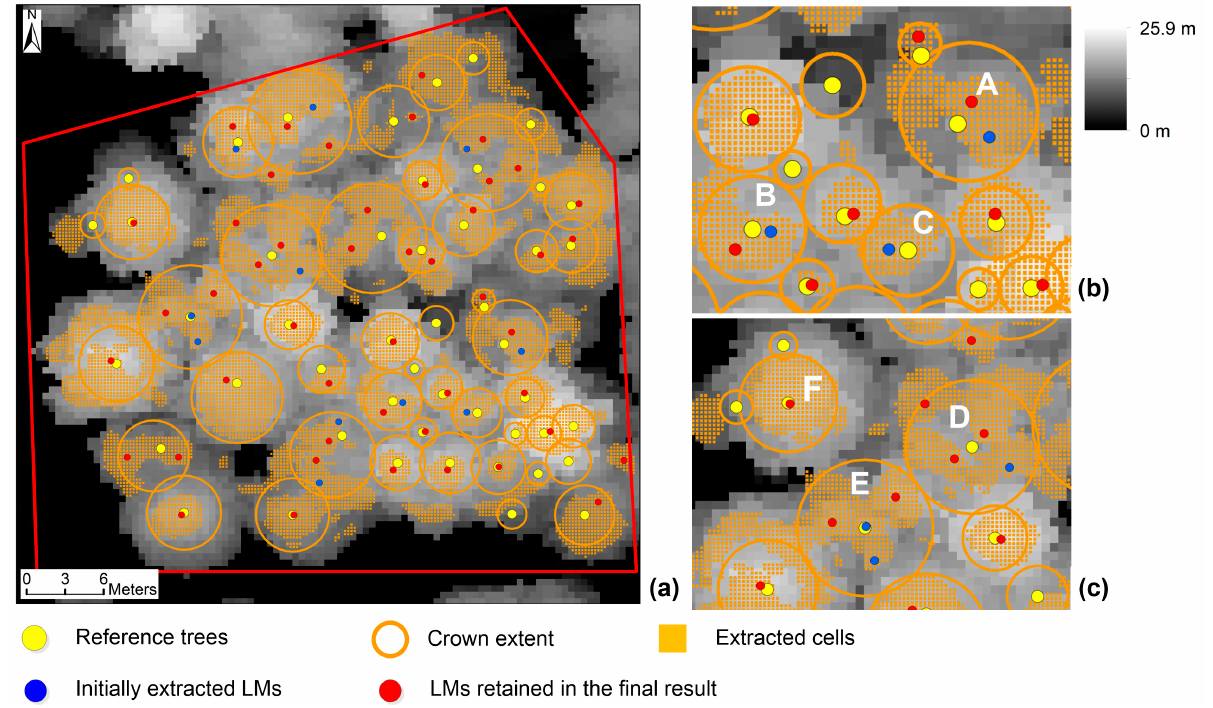
Figure 17. Tree detection result on test site 1 using the proposed approach. ( a ) Whole extent of test site 1; ( b , c ) Enlarged samples. The cells extracted through significance tests are shown in orange color. The CHM resolution is 0.25 m, the Gaussian filter size is 5 × 5, σ is 0.5 m, the LM filter size is 7 × 7, the maxD is 1.5 m, and the significance level is 0.10. The result was unaffected by the variation in score threshold.